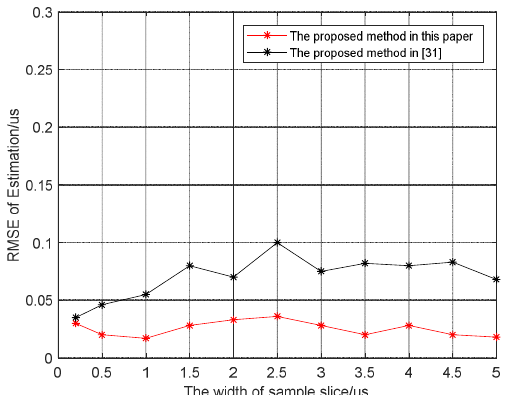
Figure 6. The root mean square error of estimated slice width varies with slice width.